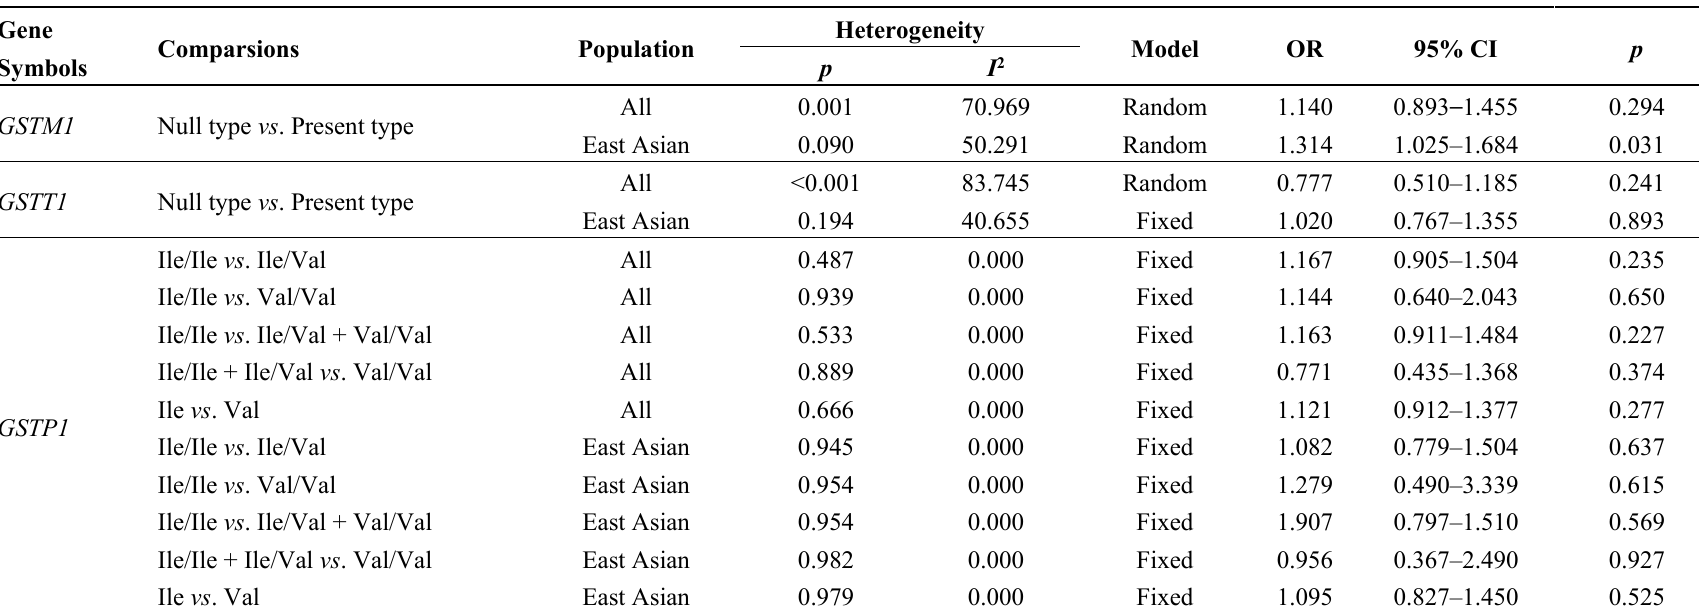
Table 2. Overall analysis between polymorphisms of glutathione S -transferase genes ( GSTM1 , GSTT1 , and GSTP1 ) and susceptibility of schizophrenia. Gene Symbols